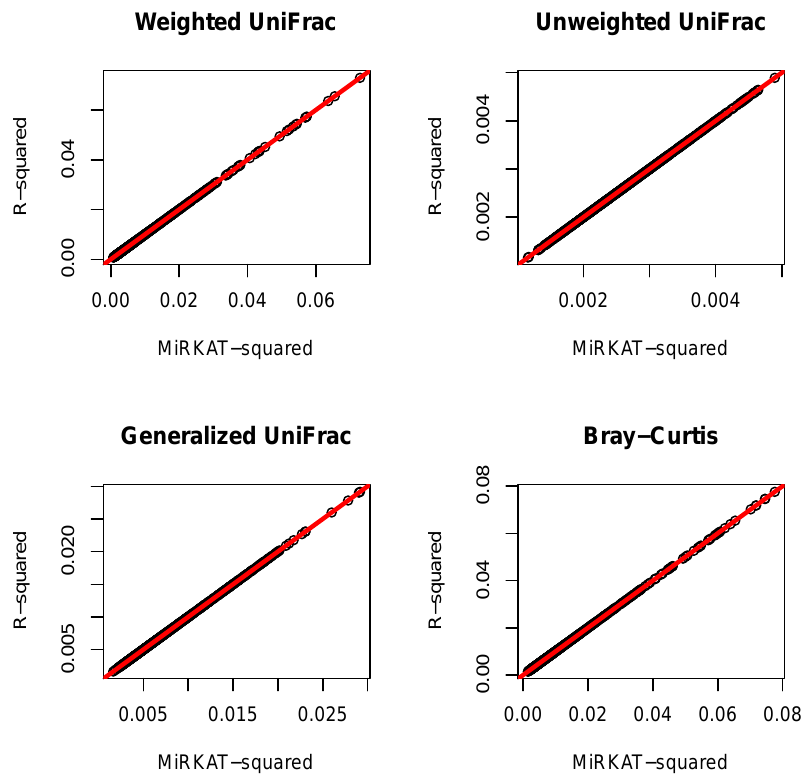
Figure 1. Comparison of MiRKAT statistic and R 2 statistic of similarity matrix regression. The red line represents the regression line, which is identical to the 45-degree line y = x